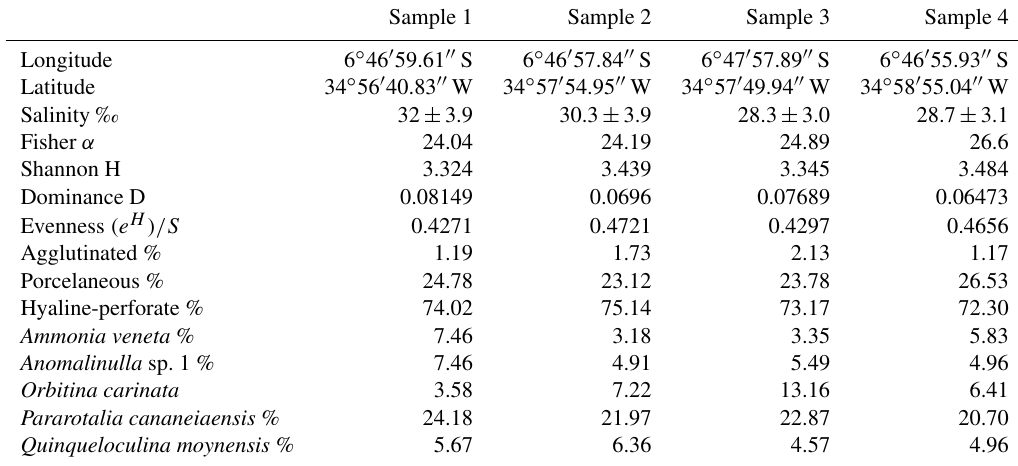
Table 2. Sample site information including geographical position, salinity (Medeiros et al., 2018), number of species, Fisher α , Shannon’s H , dominance (SID), evenness (e H )/S , and percent abundances of the agglutinated, miliolid, and perforate specimens as well as the five most abundant